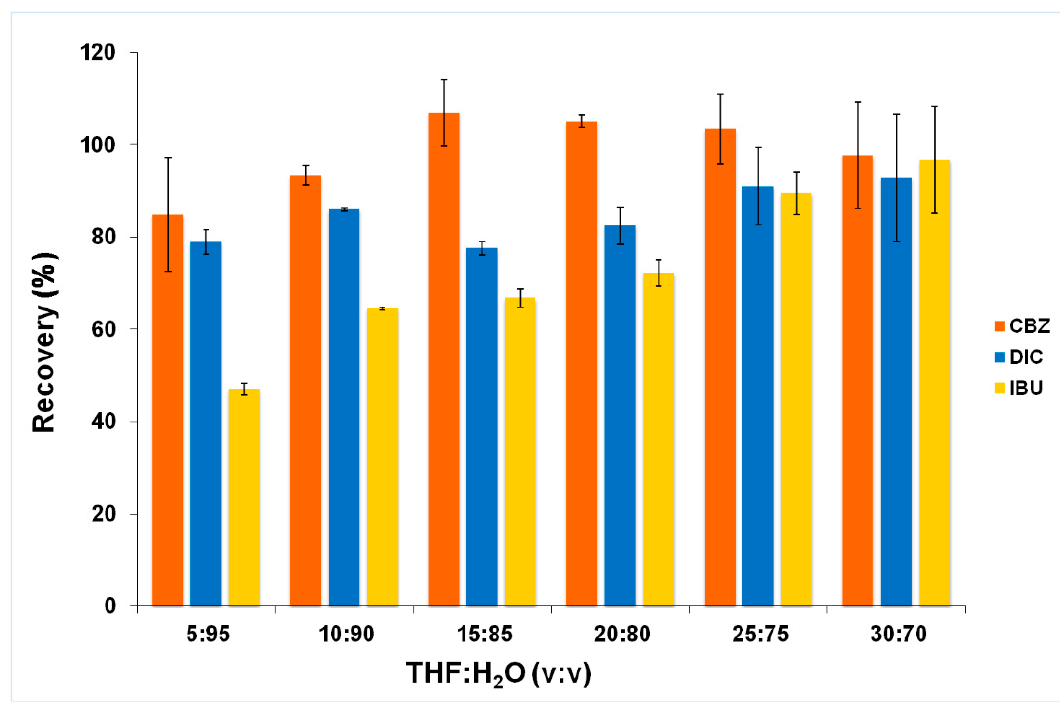
Figure 2. Effect of the THF:H 2 O volume ratio on analyte recovery. Figure 2. E ff ect of the THF:H 2 O volume ratio on analyte